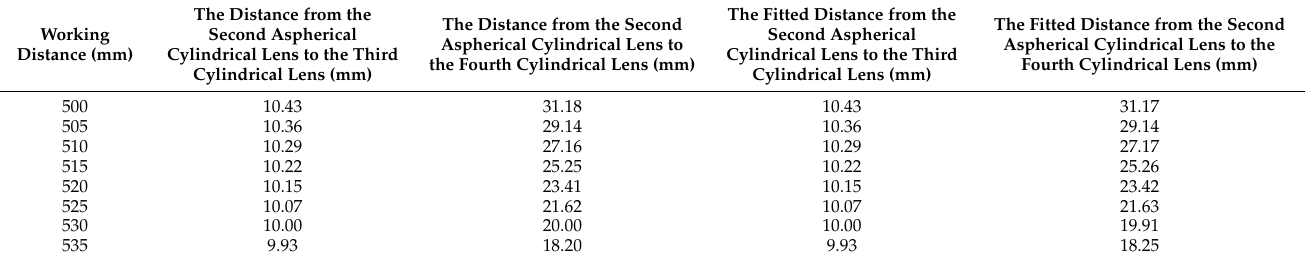
Table 6. Linear fitted displacement values of the zoom lens